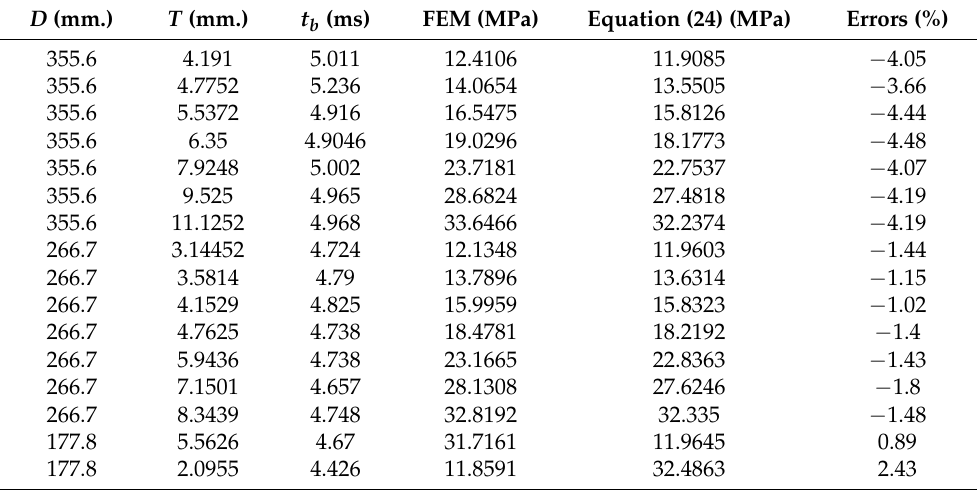
Table A4. Comparisons between the FEM results and the predictions, when t d = 3.9 ms. D